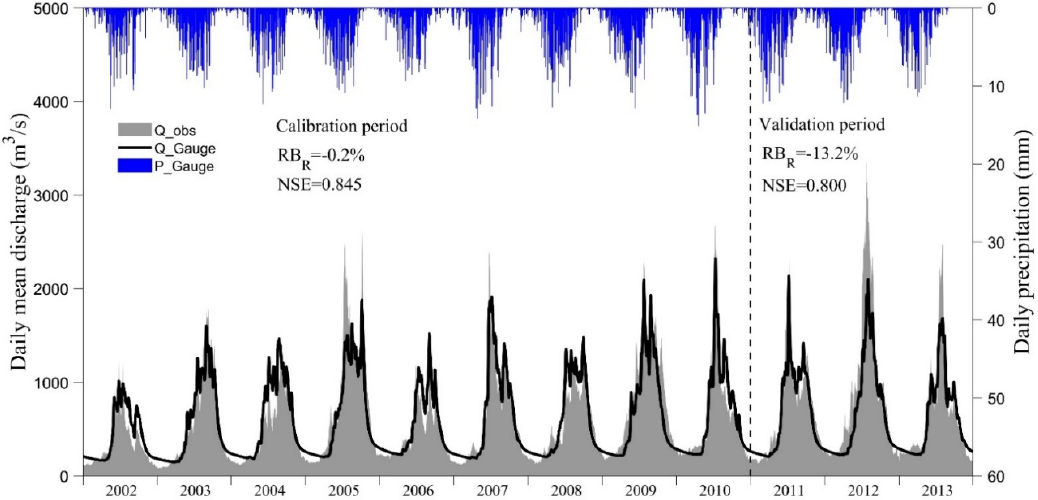
Figure 7. The VIC-based simulated daily hydrograph at the Tangnaihai hydrological station using the rain-gauge-based precipitation data in the calibration period (1 January 2002–31 December 2010) and validation period (1 January 2011–31 December 2013) (Q_obs denotes the observed discharge; Q_Gauge represents the simulated discharge using the gauge-based precipitation data; and P_Gauge is the rain-gauge-based basin-averaged